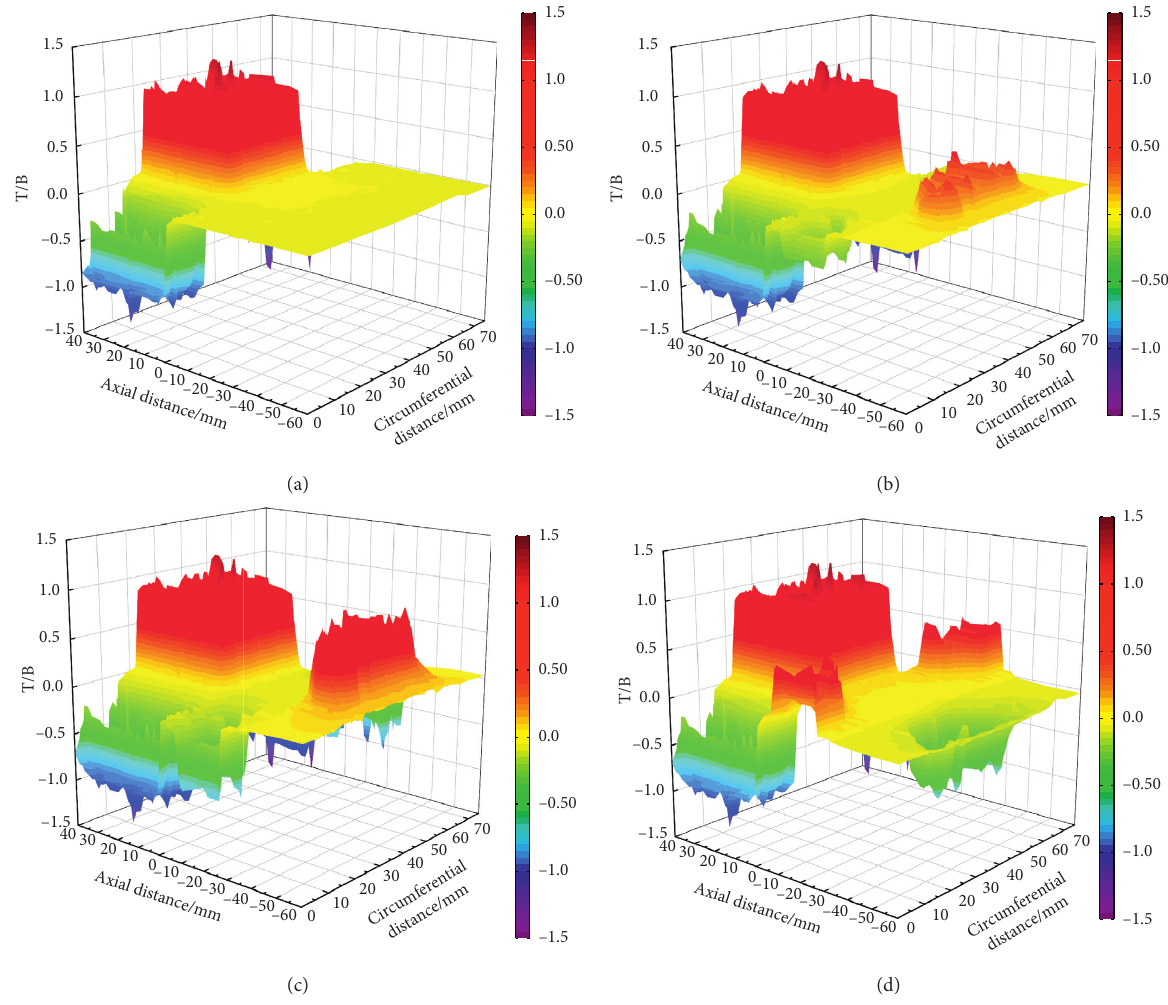
Figure 14: Radial flux density with excitation current. (a) I output voltage. In Figure 15, when the excitation current is 5 A and 6 A, the two waveforms of the EMF are almost the same. It indicates that the magnetic flux density of claw pole